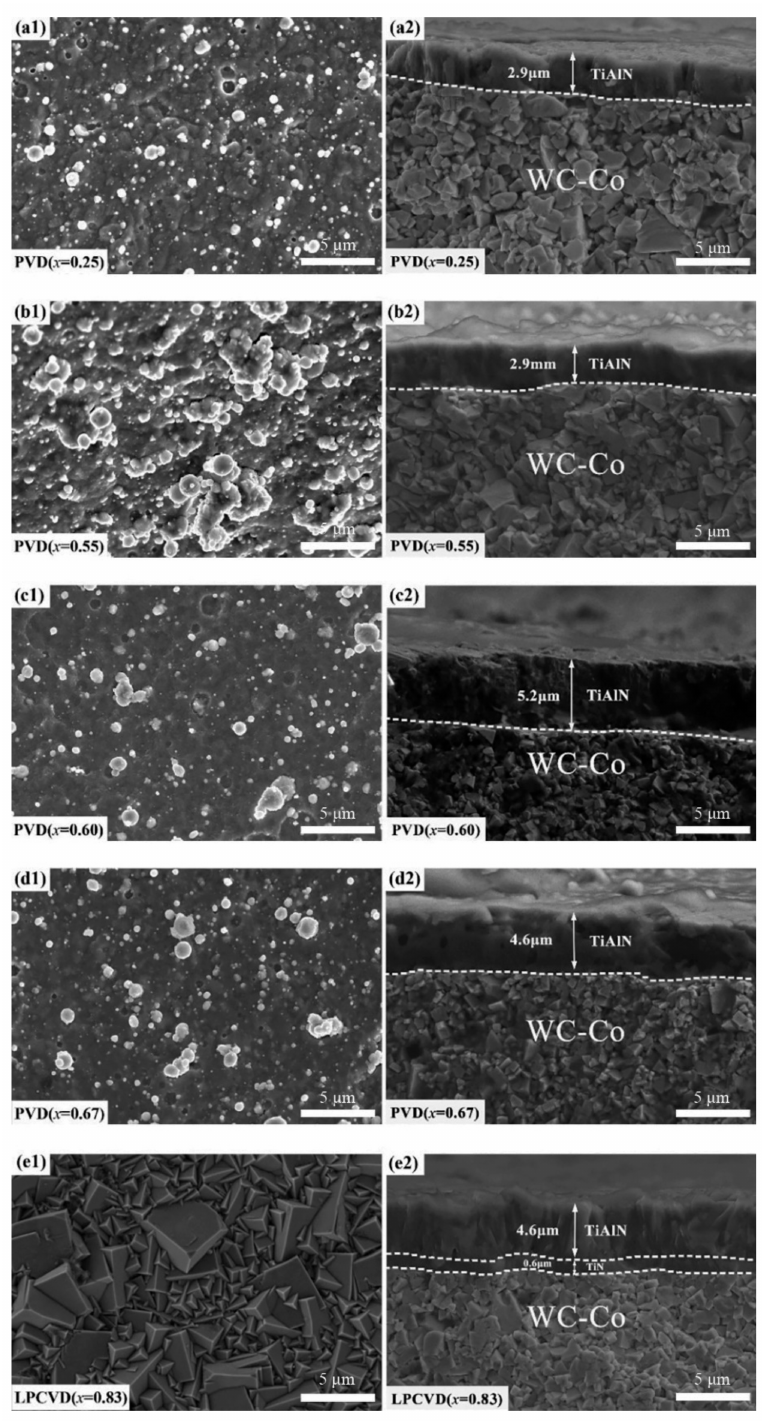
Figure 2. ( a1 – e1 ) Surface and ( a2 – e2 ) fracture morphologies of the Ti 1 − x Al x N